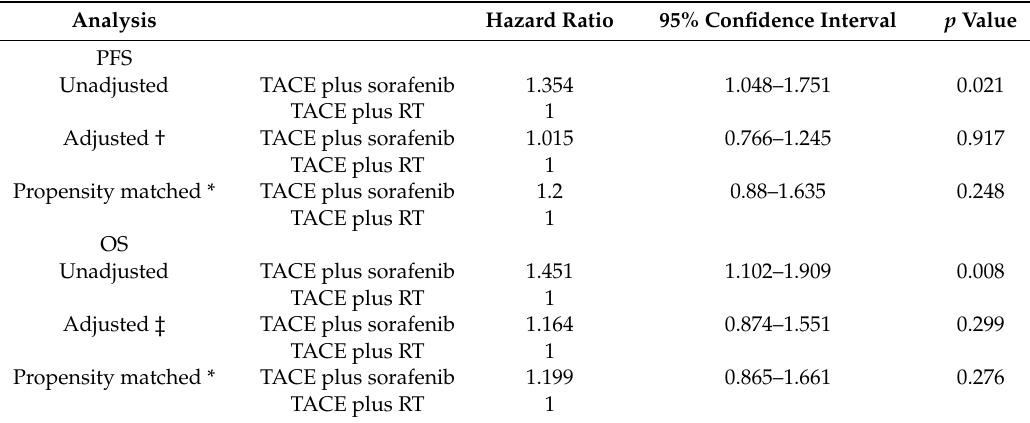
Table 2. Results of Cox proportional hazard models.